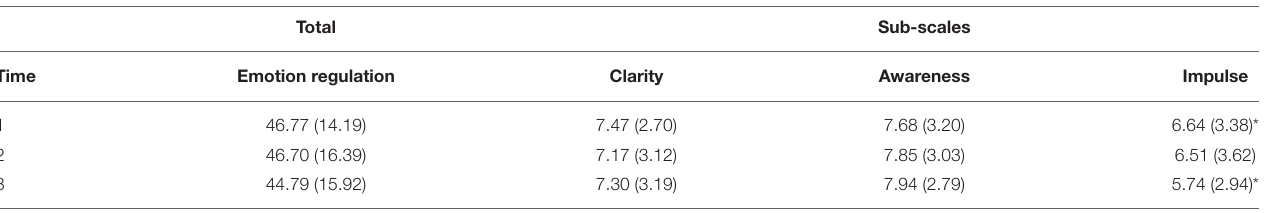
TABLE 4 | Overview of DERS-SF total and sub-scale